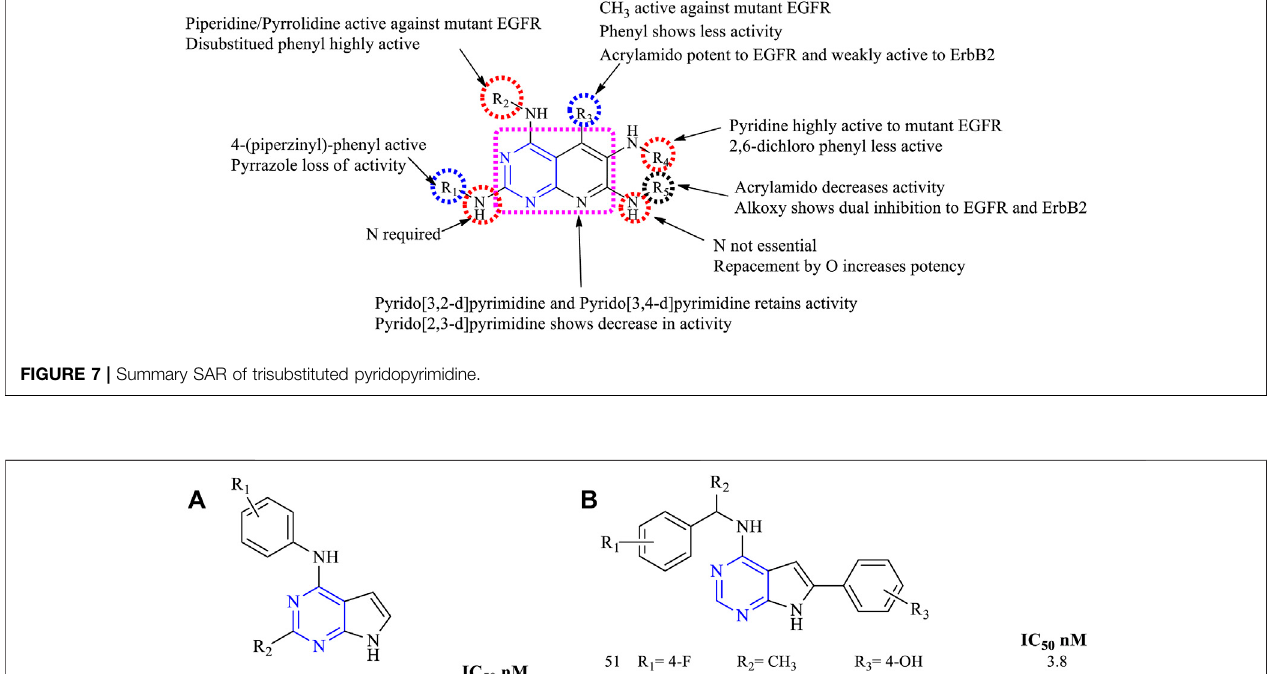
Frontiers in Chemistry |